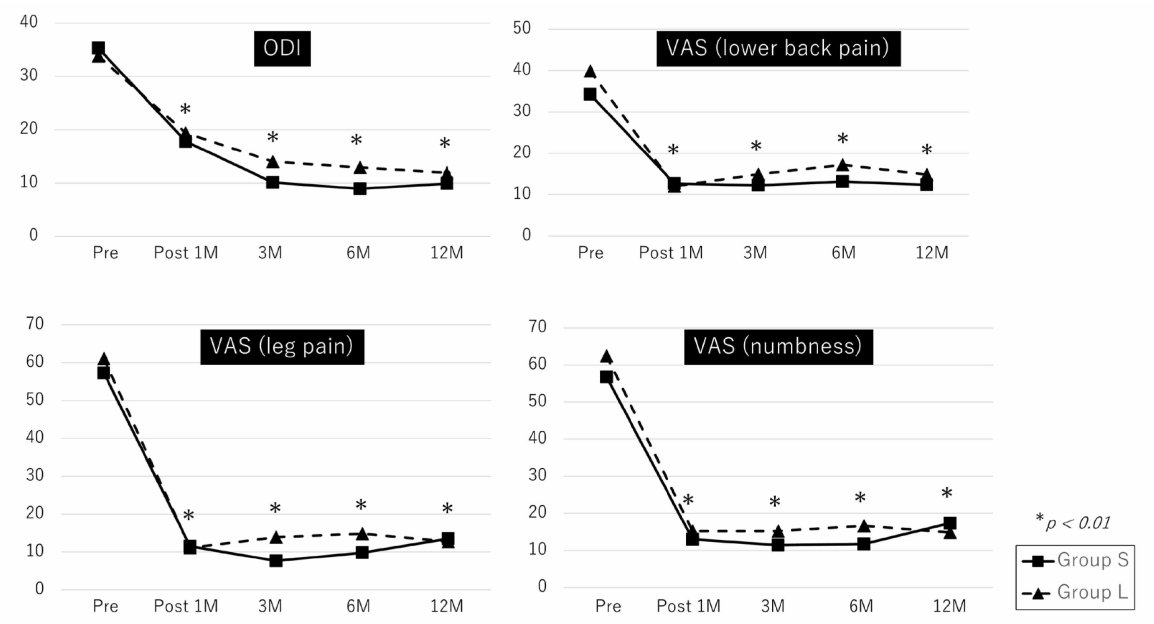
Figure 2. Comparison of preoperative and postoperative ODI scores, lower back pain, leg pain, and numbness VAS scores. All parameters showed significant improvement from the preoperative baseline to any time point after surgery. * p < 0.01; ODI, Oswestry Disability Index; VAS, Visual Analog Scale. Table 2. The comparison of clinical outcomes at preoperative and all follow-up periods (All patients). Group S Group L p Value 95% CI Preoperative ODI